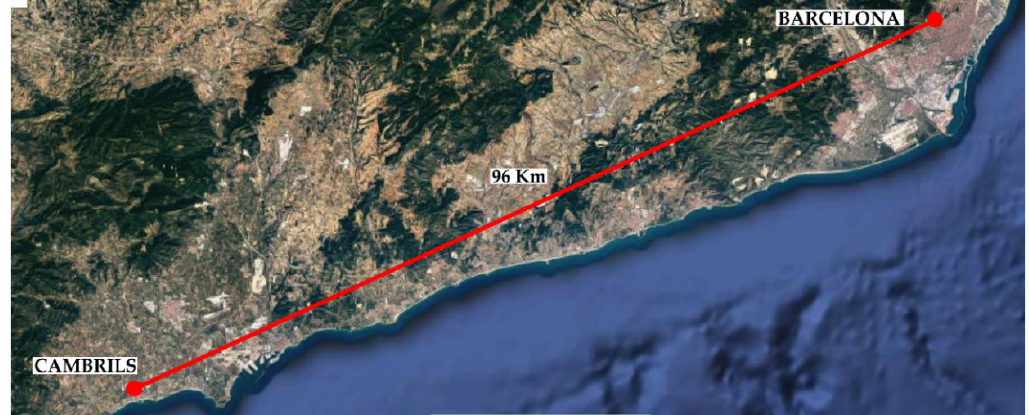
Figure 4. Near vertical incidence skywave (NVIS) test link.